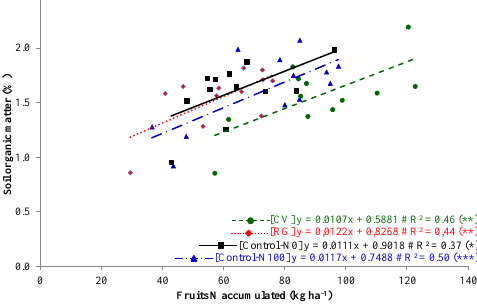
Figure 4. Soil organic matter at green manuring plotted against fruits N accumulated at pepper harvesting in common vetch (CV), ray grass (RG), control unfertilized (Control-N0), and control fertilized (Control-N100). The data fit with linear regression models. The significance level is (*), (**) or (***) at P < 0.05, P < 0.01 or P < 0.001, respectively. Table 4. The main effect of growing periods, intensification level, and soil tillage on marketable fruit yield and yield characteristics of pepper crop. Values belonging to the same variable followed by the same letter are not statistically different, according to LSD (0.05).